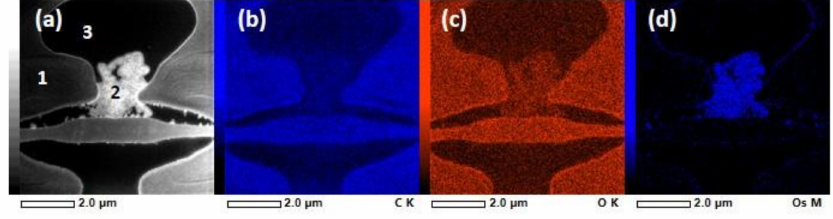
Figure7. STEM-EDSofresin-embeddedknotwoodtracheidwithsomedepositmaterial. ( a )STEMimage with region numbers corresponding to Table 4. EDS images showing ( b ) C K α , ( c ) O K α and ( d ) Os M α X-ray